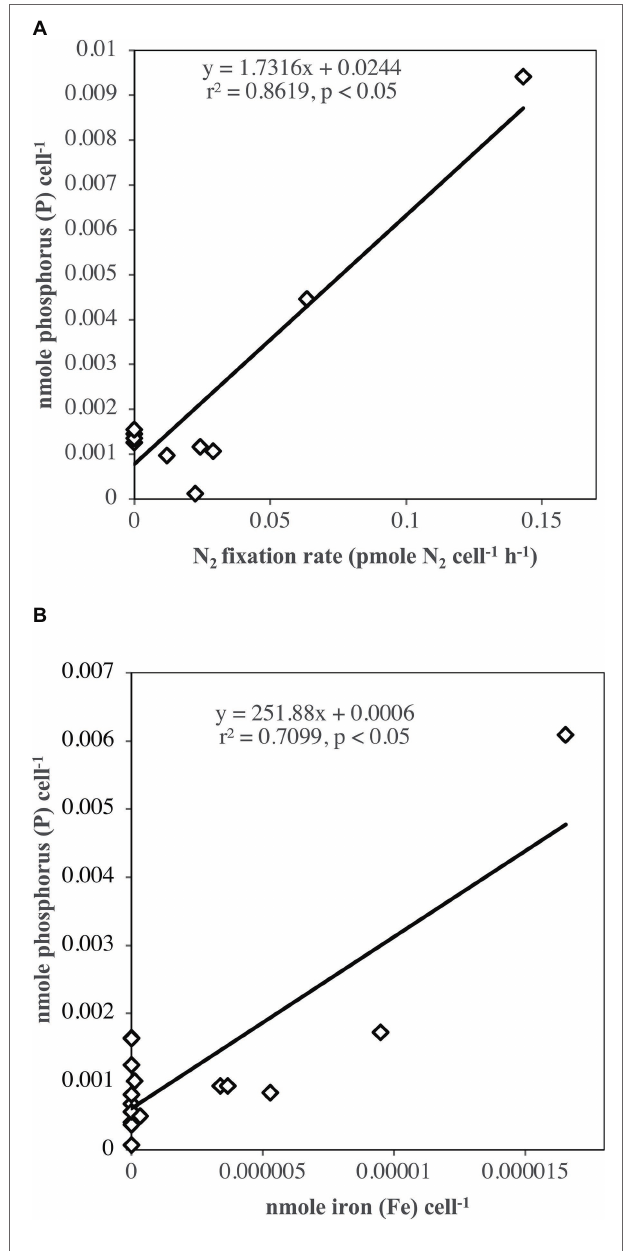
FIGURE 9 | Linear regression analyses (A) between P-cellular content and N 2 fixation and (B) between P and Fe-cellular content. Cellular content was measured in [Low 3 NO - ] using pooled data from all 3 combination